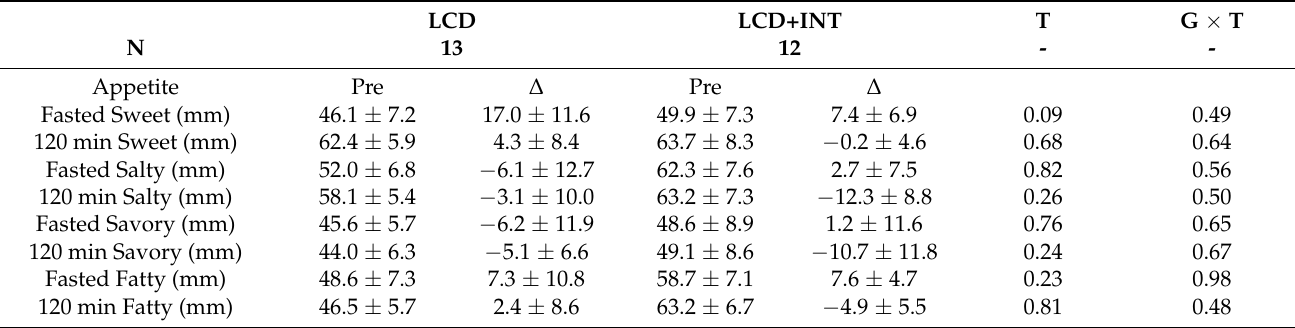
Table 3. Perceived